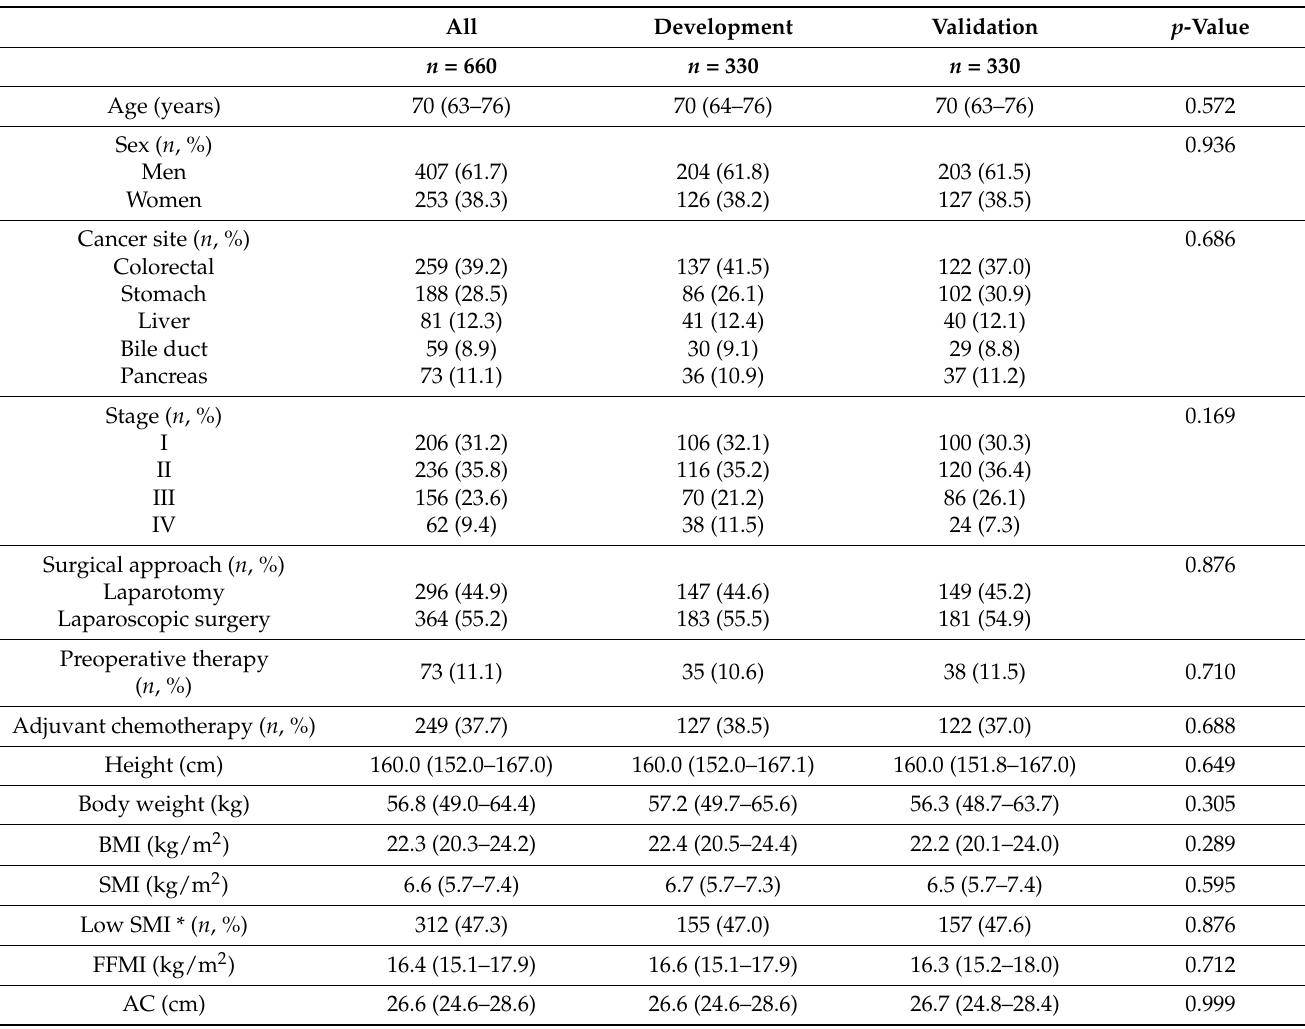
Table 1. Patient